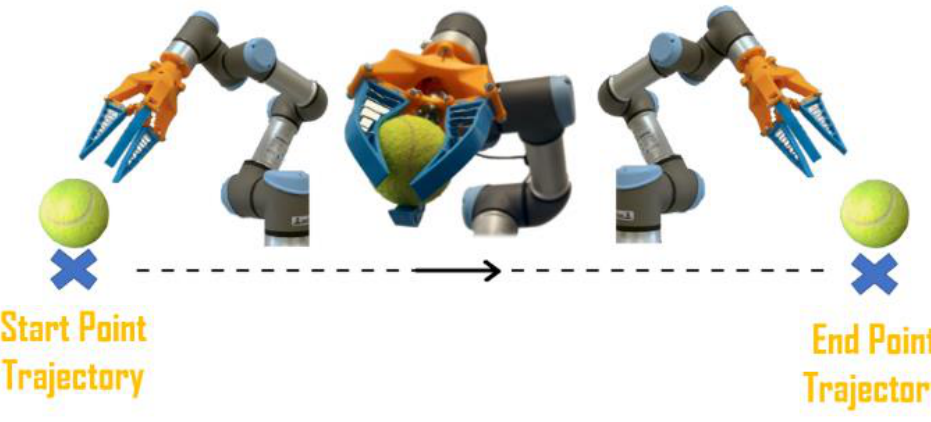
Figure 8. Test execution: the gripper picks up one of the twelve objects in a predetermined position and place it in the desired location.